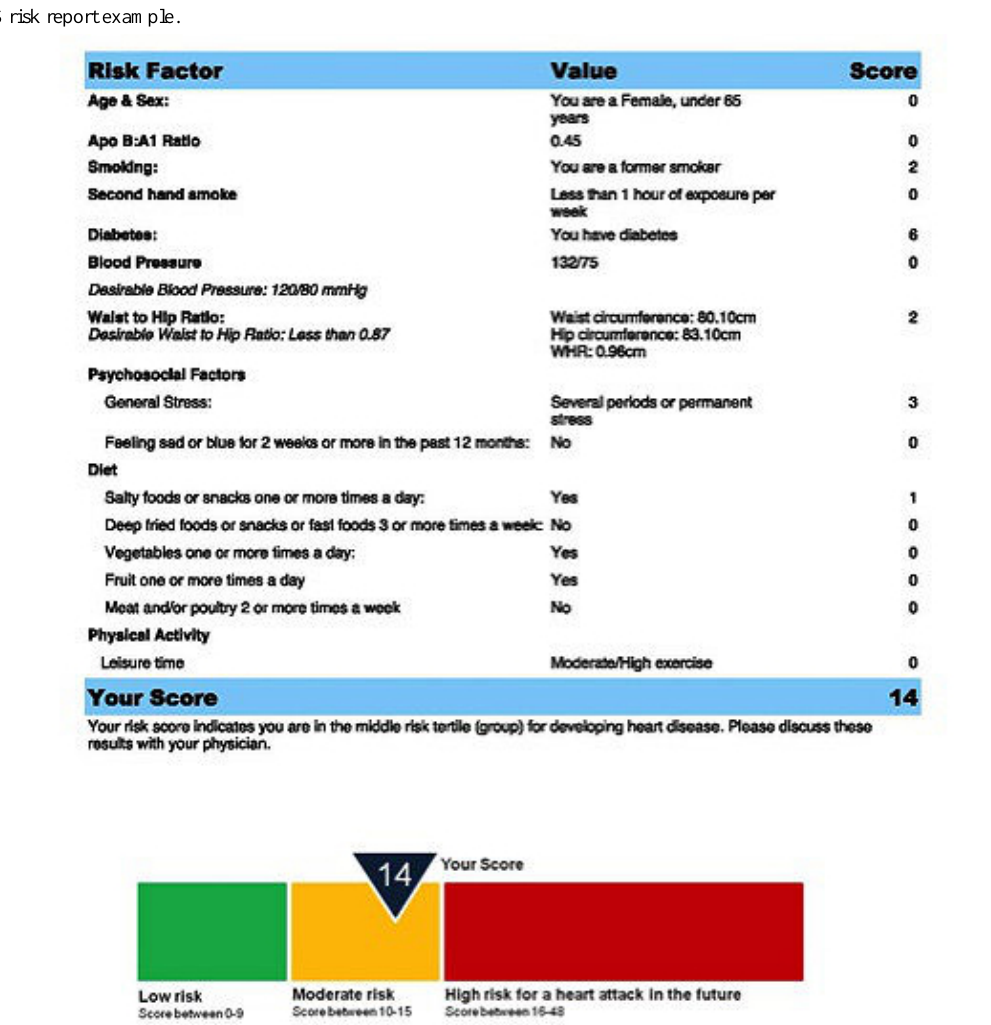
Figure 1. IHRS risk report example.